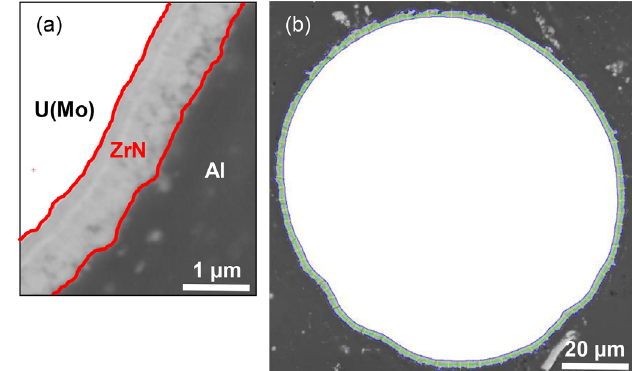
Fig. 1. Principle of ZrN coating thickness measurement, on BSE images: (a) detection of ZrN layer boundaries, (b) measurement of ZrN layer thickness at 100 locations around the particle.